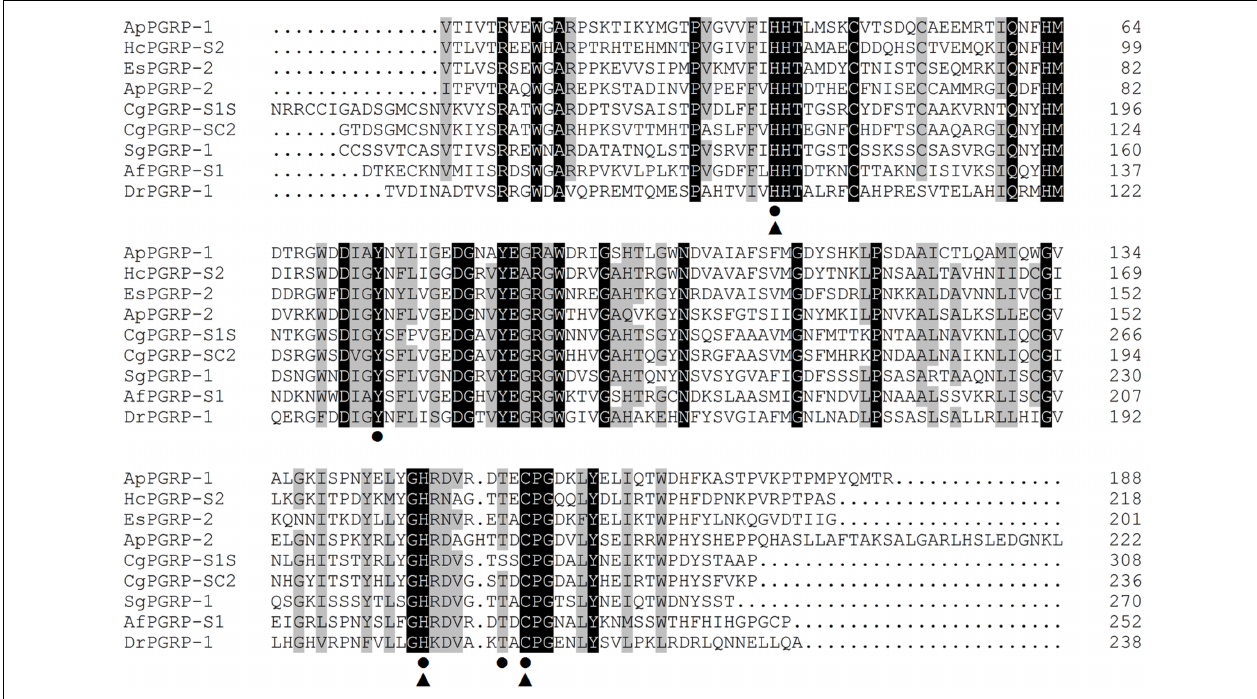
FIGURE 2 | Alignments of amino acid sequences of ApPGRP-1 and -2 with other species. Zn 2 + binding sites and amidase catalytic sites are marked with triangles (cid:78) and cycles • , respectively. Amino acid residues that are conserved in at least 75% sequences are shaded in gray, and 100% identity amino acids are shaded in black. Species include CgPGRP-S1S ( Crassostrea gigas , BAG31896), AfPGRP-S1 ( Azumapecten farreri , AAY53765), SgPGRP-1 ( Solen grandis , JN642118), EsPGRP-2 ( Euprymna scolopes , AAY27974) and DrPGRP-1 ( Danio rerio , NP_001037786), HcPGRP-S2 ( Hyriopsis cumingii , AHK22786.1), and CgPGRP-SC2 ( C. gigas ,